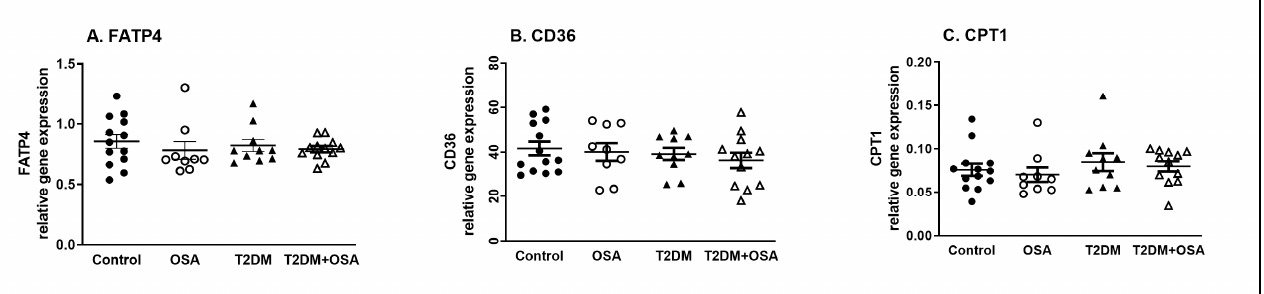
Figure 3. Relative gene expression of FATP4, CD36 , and CPT1 in muscle biopsies. Quantitative real-time PCR was employed to assess the gene expression of ( A ) fatty acid transport protein 4 ( FATP4 ), ( B ) platelet glycoprotein 4 ( CD36 ), and ( C ) carnitine-palmitoyl transferase I ( CPT1 ), relative to the expression of the reference genes for β‐ glucuronidase and TATA box binding protein (geometric mean of the two). The relative gene expression values of all groups are expressed as 2 ^ Δ CT . Data are presented as individual values and error bars displaying the mean ± SEM; an ANOVA test was performed to assess differences between the groups.